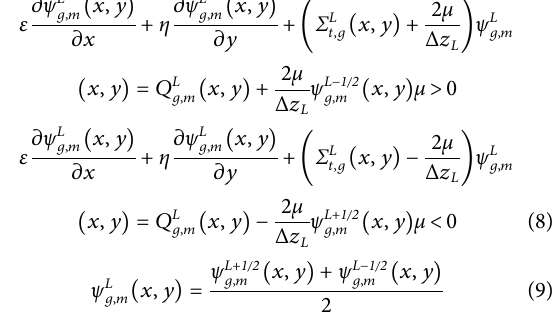
FIGURE 11 Con fi gurations of advanced PWR whole-core problem.